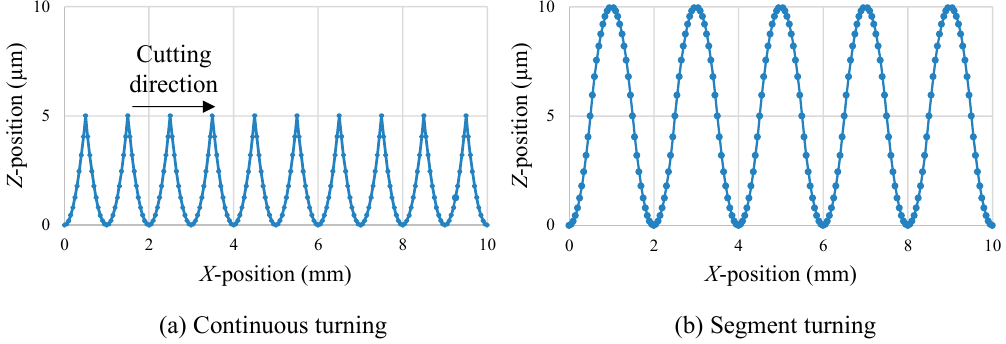
Figure 13. Input tool paths for calculating machine tool position errors when cutting concave spherical lenslets. ( a ) Continuous turning; ( b ) segment turning.